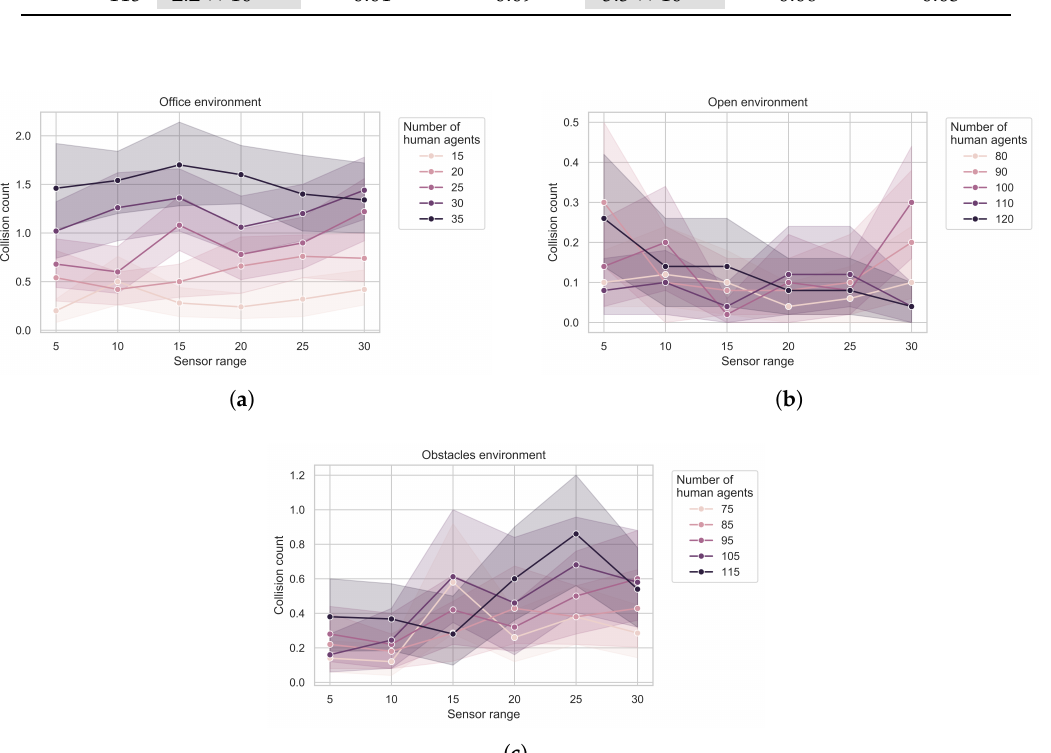
Figure 5. Mean and 95% confidence intervals (shaded area) of the collision counts during navigation in the ( a ) office, ( b ) open and ( c ) obstacles environment as a function of sensor range and number of